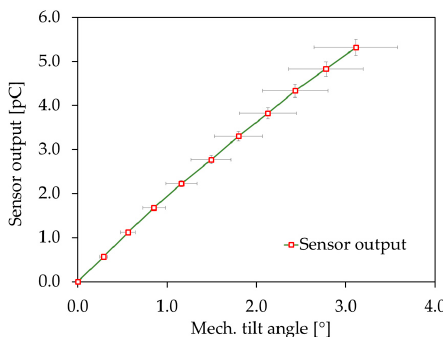
Figure 29. Sensor output charge versus mechanical tilt angle for Design 1-S in resonant operation (average of four sensor elements). The x- and y-axis error bars are the measured median absolute deviations.